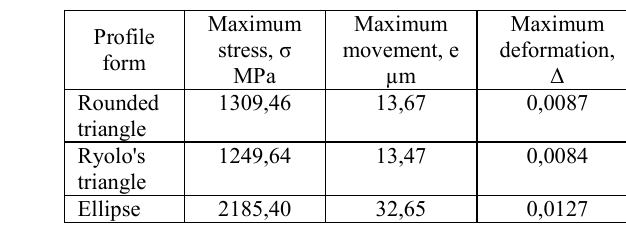
Table 2. Maximum v alues o f s tresses, d isplacements an d deformations using various special profiles